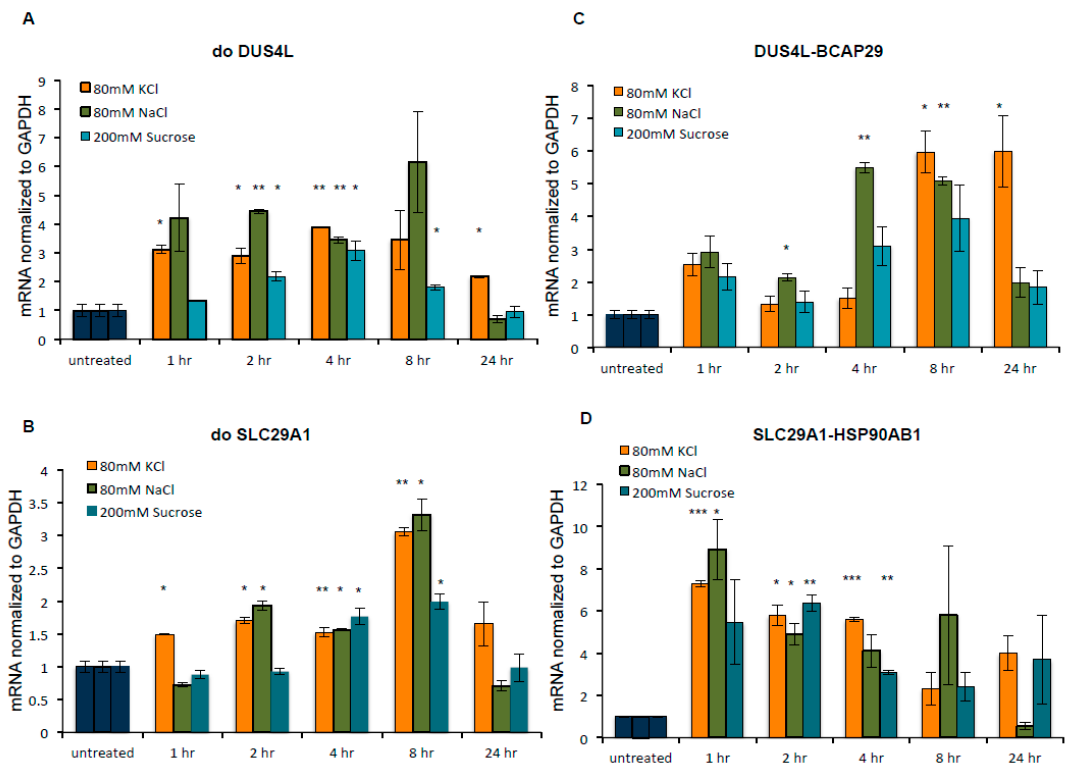
Figure 6. The upregulation of DoGs and cis-SAGe fusions persisted after osmostress. HEK293 cells were first treated with KCl, NaCl, or sucrose for 24 h to induce changes in DoGs and fusion RNAs. The stress was then removed, and time points were collected at 1 h, 2 h, 4 h, 8 h, and 24 h after the wash-off. DoGs and cis-SAGe fusion RNAs were measured by qPCR. The levels of various transcripts were normalized to that of GAPDH and further normalized to the untreated samples. Examples of DoGs, doDUS4L ( A ) and doSLC29A1 ( B ), as well as representative cis-SAGe fusion RNAs DUS4L-BCAP29 ( C ), and SLC29A1-HSP90AB1 ( D ) are shown here. *: p < 0.05, **: p < 0.01, ***: p <0.001.